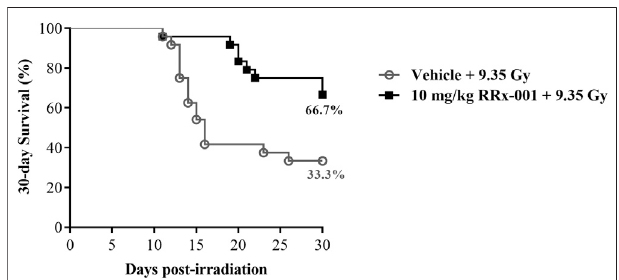
FIGURE 1 | Kaplan – Meier 30-day survival curves illustrating the increasedandprolongedsurvivalofCD2F1miceprophylacticallytreatedbyIP injection with 10 mg/kg RRx-001 compared to the vehicle control, 24 h prior to9.35 Gywholebodyirradiation;log-rank χ 2 ( 1 ) (cid:1) 7.65, p (cid:1) 0.006. N (cid:1) 12 mice/group (24 mice total) per experiment. The experiment was performed in duplicate (48 mice